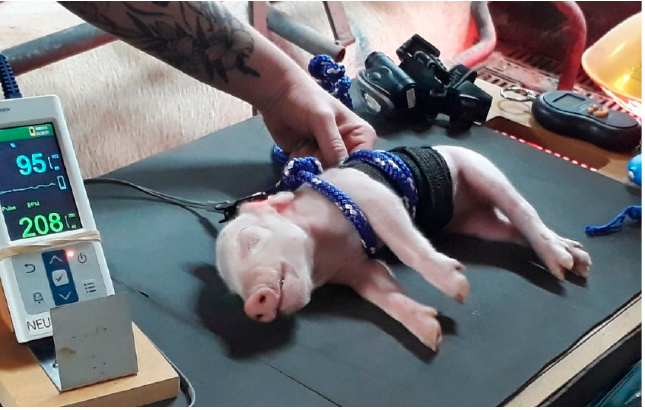
Figure 1. Rope squeeze applied to the thorax of a piglet, with vet wrap secured underneath the rope and pulse oximetry electrode attached to the